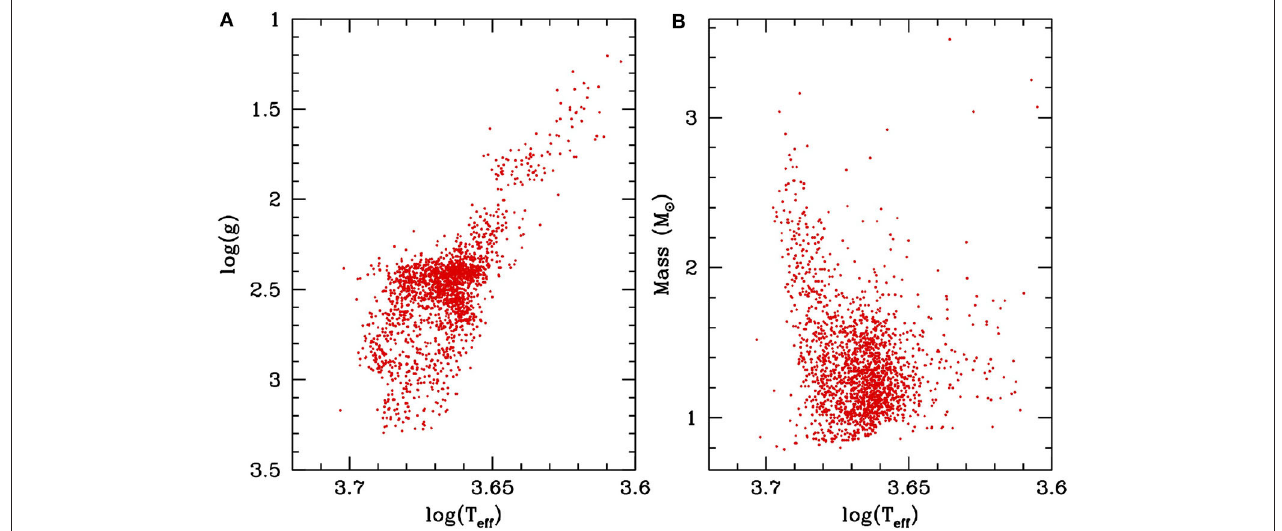
FIGURE 8 | Asteroseismically derived surface gravity (A) and mass (B) of the sample of red giants in Pinsonneault et al. (2014). The over-density of points in (A) around log g 2.5 is caused by the presence of red-clump stars. There is a corresponding over-density in masses, though here the overdensity is confined to low ∼ masses; higher-mass stars do not form red-clump stars.